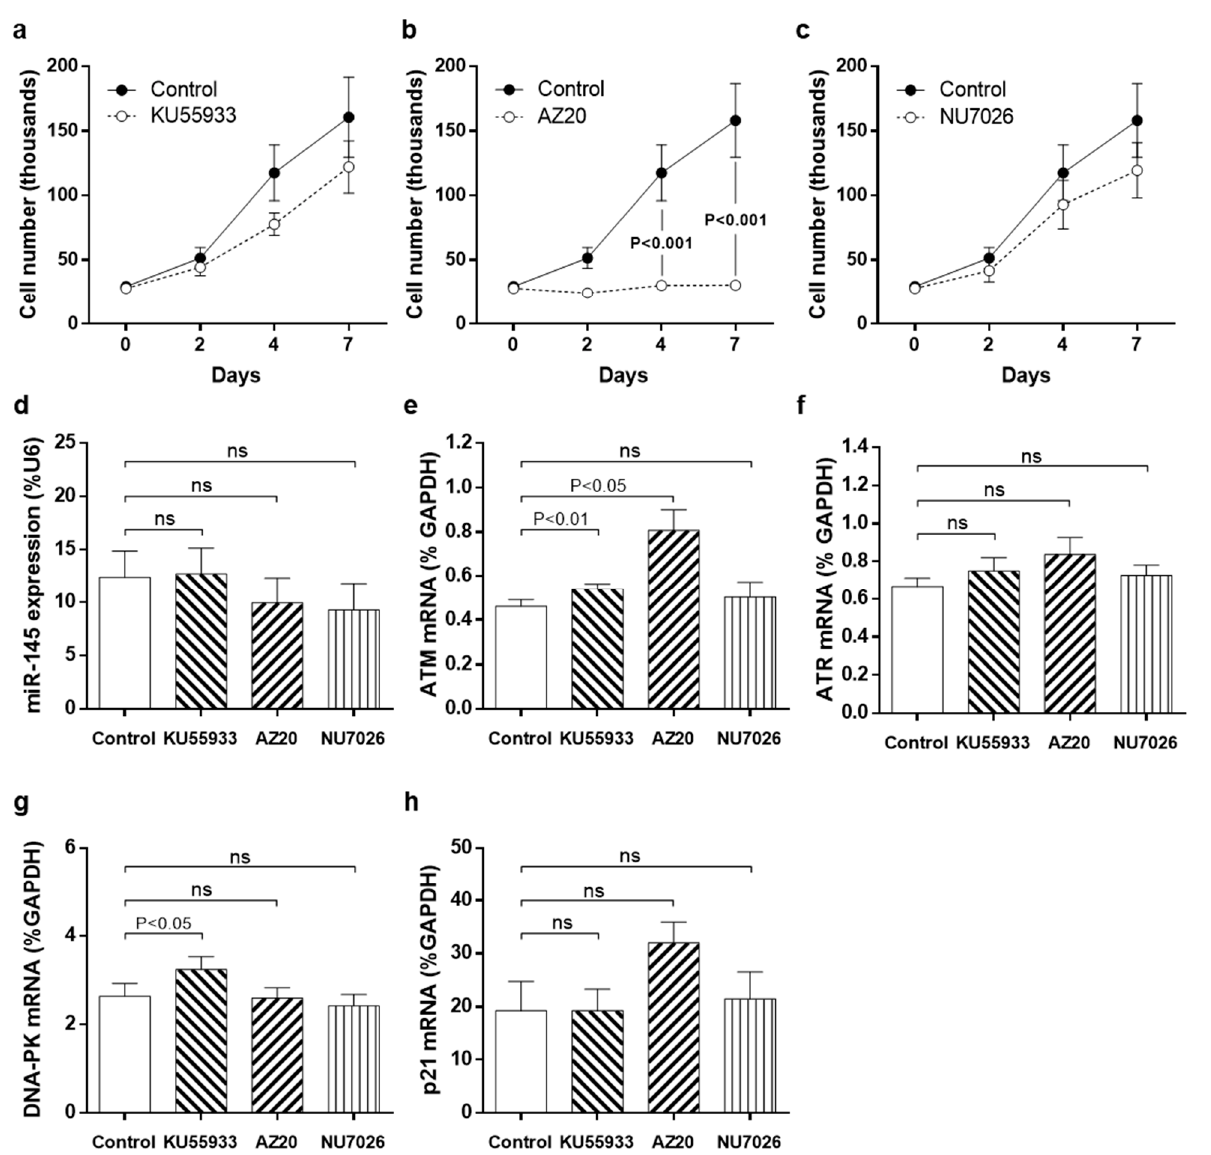
Figure 3. Pharmacological inhibition of apical kinases of the DNA damage response pathway modulates proliferation and gene expression. ( a ) SMC were treated with ATM inhibitor (KU55933; 10 µ M), ( b ) ATR inhibitor (AZ20; 10 µ M) or ( c ) DNA-PK inhibitor (NU7026; 3 µ M) for up to 7 days and cell counts performed on days 0, 2, 4 and 7 ( n = 4). After 72 h, RNA was extracted and the effect of all inhibitors on expression of ( d ) miRNA-145 , ( e ) ATM , ( f ) ATR , ( g ) DNA-PK and ( h ) p21 was measured using RT-PCR (all n = 6). ns = non-significant.